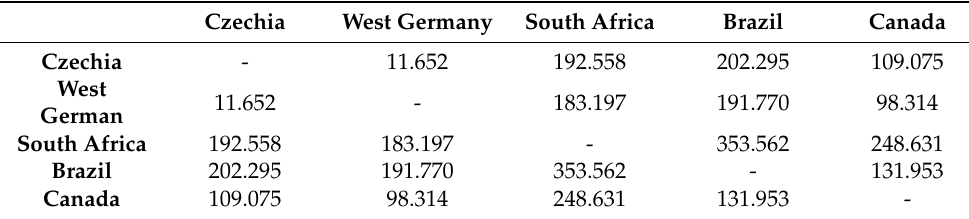
Table 3. Measured communication RTT in ms between the sites used in the